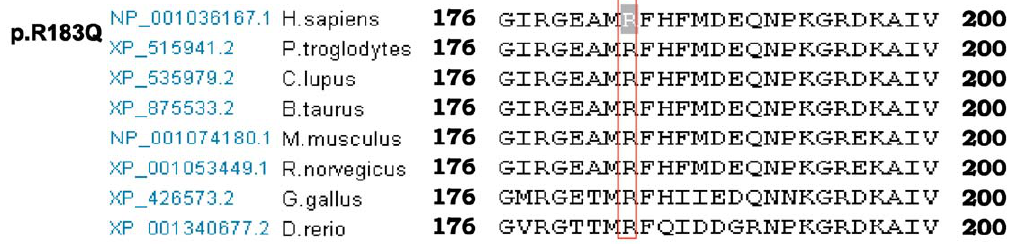
Figure 6. Evolutionary conservation of the residue altered in the PJVK gene. The ClustalW of pejvakin are shown among different organisms, including human, Chimpanzee, dog, cattle, mouse, rat, bird and fish. The locations of mutated amino acids are boxed and highlight in inversed color.